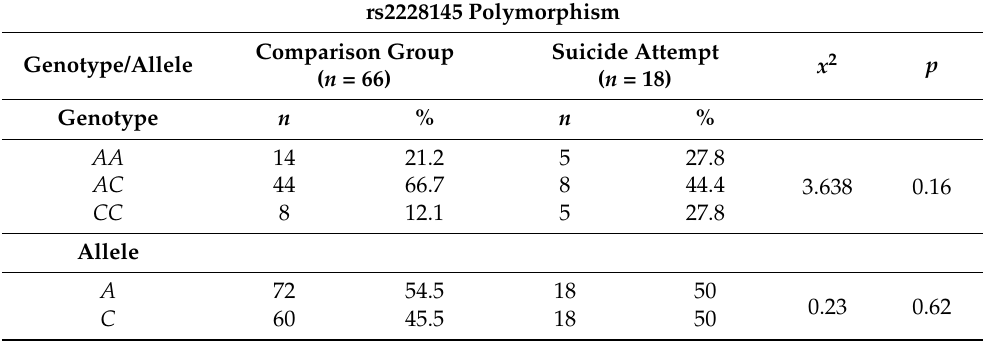
Table 2. Genotype and allele distribution of IL-6R rs2228145 in the suicide attempts and the compari- son group. rs2228145 Polymorphism Comparison Group Suicide Genotype/Allele ( n = 66)